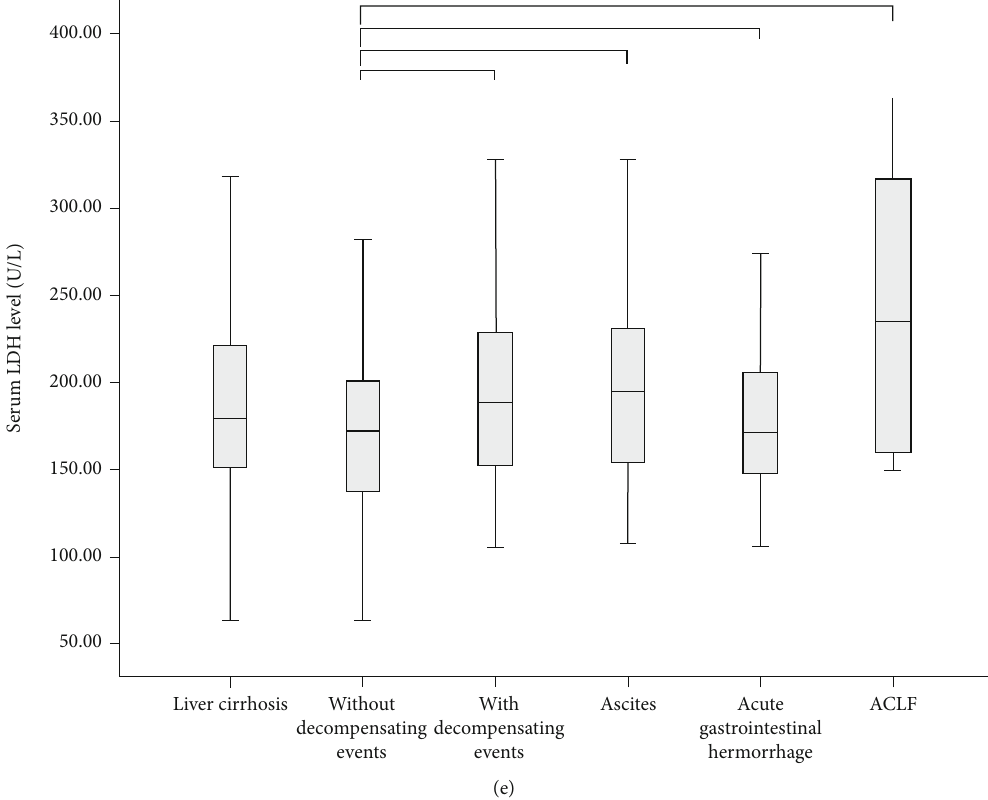
Figure 2: Box plots showing the concentrations of serum NT-pro BNP (a), hs-cTnT (b), CK (c), CK-MB (d), and LDH (e) in general cirrhotic patients, cirrhotic patients with and without decompensating events, cirrhotic patients with ascites, cirrhotic patients with acute gastrointestinal hemorrhage, and cirrhotic patients with ACLF. Notes: ∗∗ P < 0 : 001 and ∗ P < 0 : 05